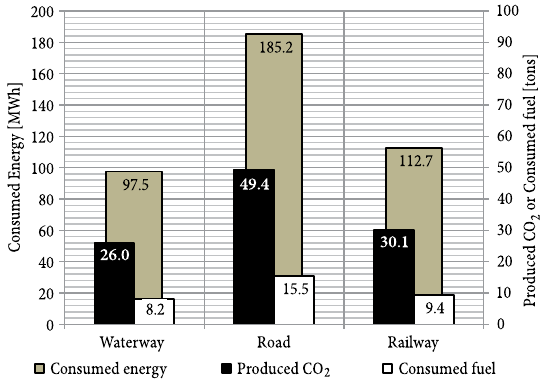
Estonia.Fig. 5. Energy consumption and CO 2 emission per mode of transport service